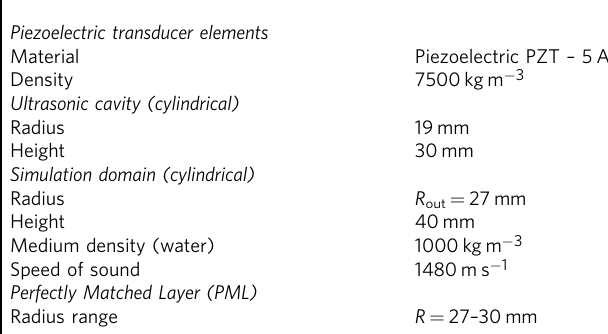
Table 1 Material and geometrical properties used in the